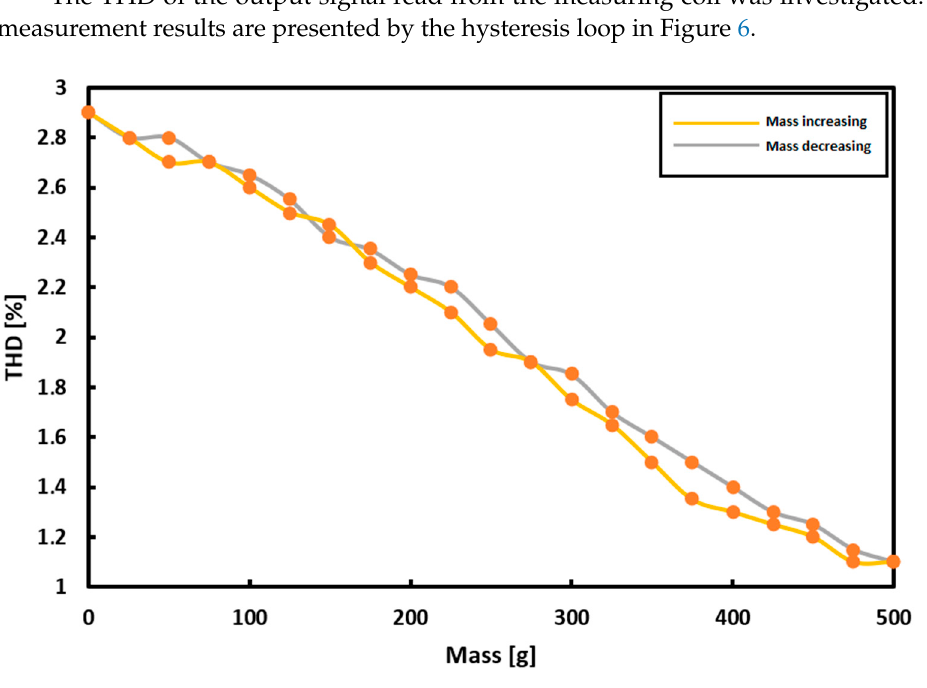
Figure 6. Measurement results of THD of output signal.